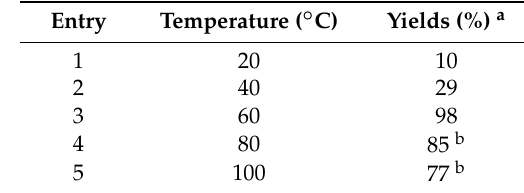
Table 4. Temperature effect on product yields. Reaction conditions: 4-toluidine (1 mmol);